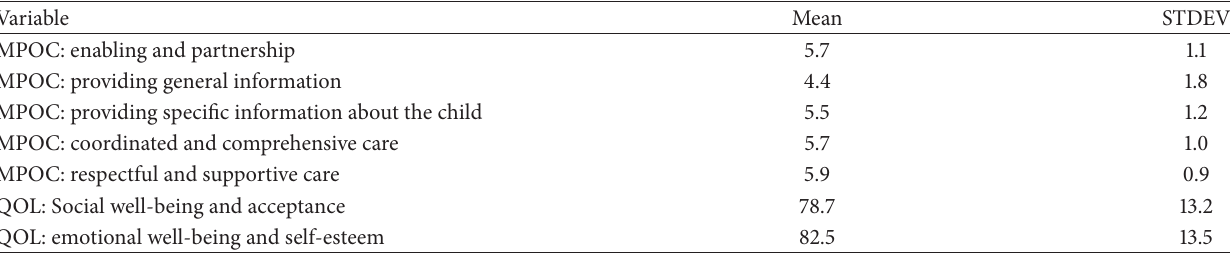
Table 2: Mean scores for MPOC-20 and QOL domains.